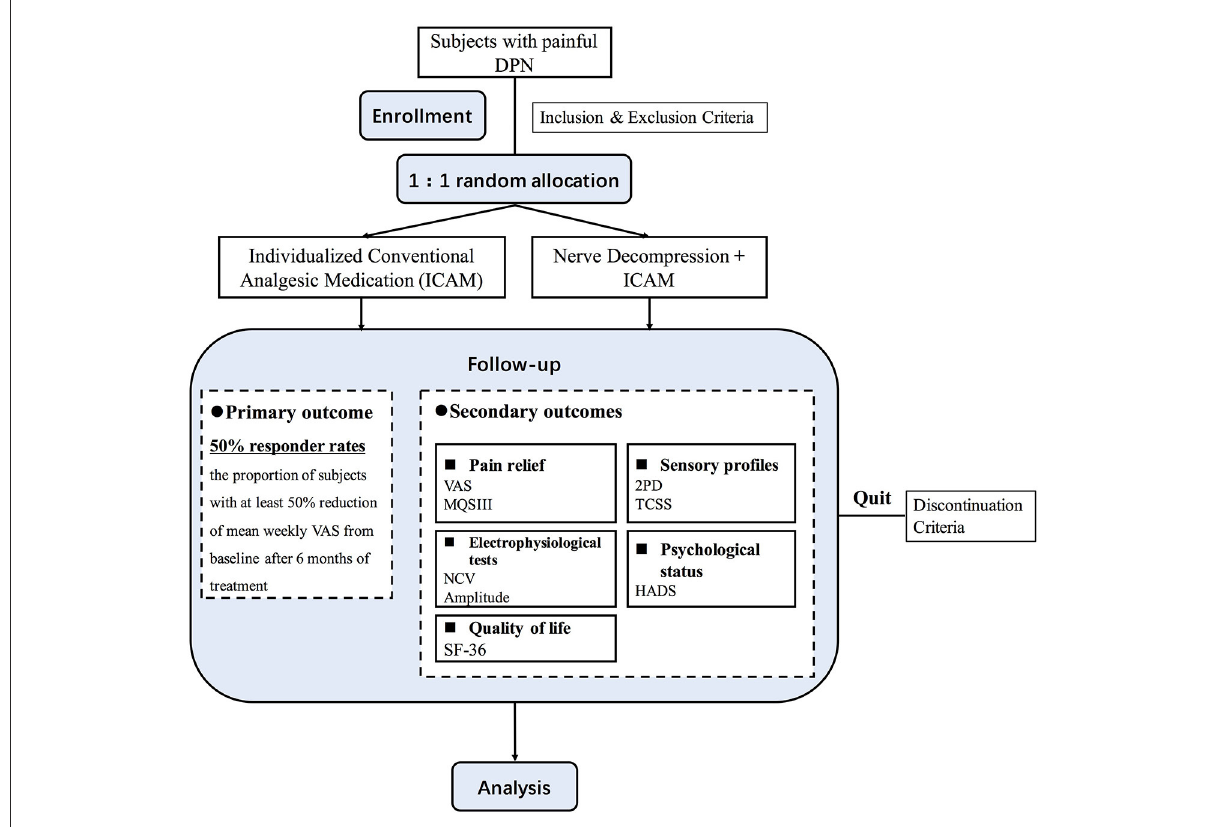
FIGURE1 A study flow